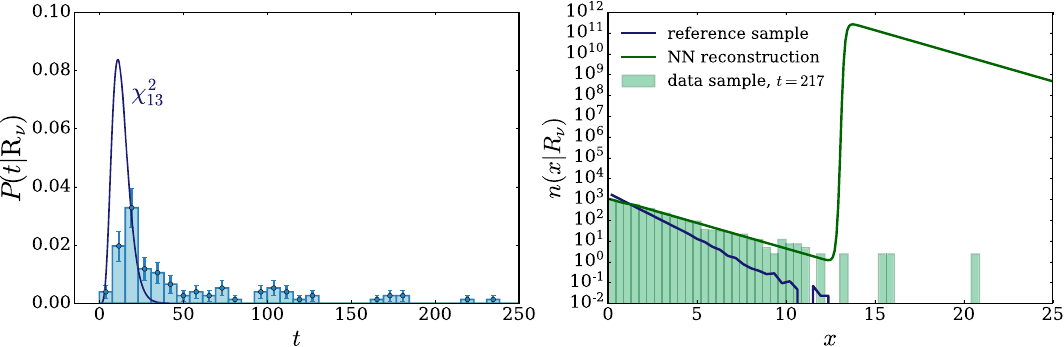
Fig. 6 The empirical distribution of t computed with 100 toy experiments for (ν ∗ n ,ν ∗ s ) = ( 0 , − 0 . 6 ) . Increasingly accurate modelings of log (cid:7) r ( x ; ν ) are employed in the three panels, namely the linear- and quadratic-order approximations and the analytic log-ratio in Eq. (30)